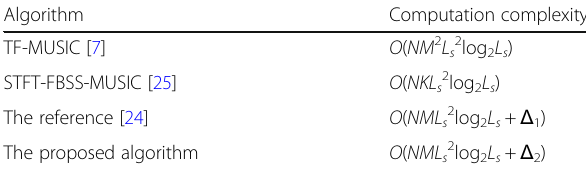
Table 1 Comparison of computation complexity